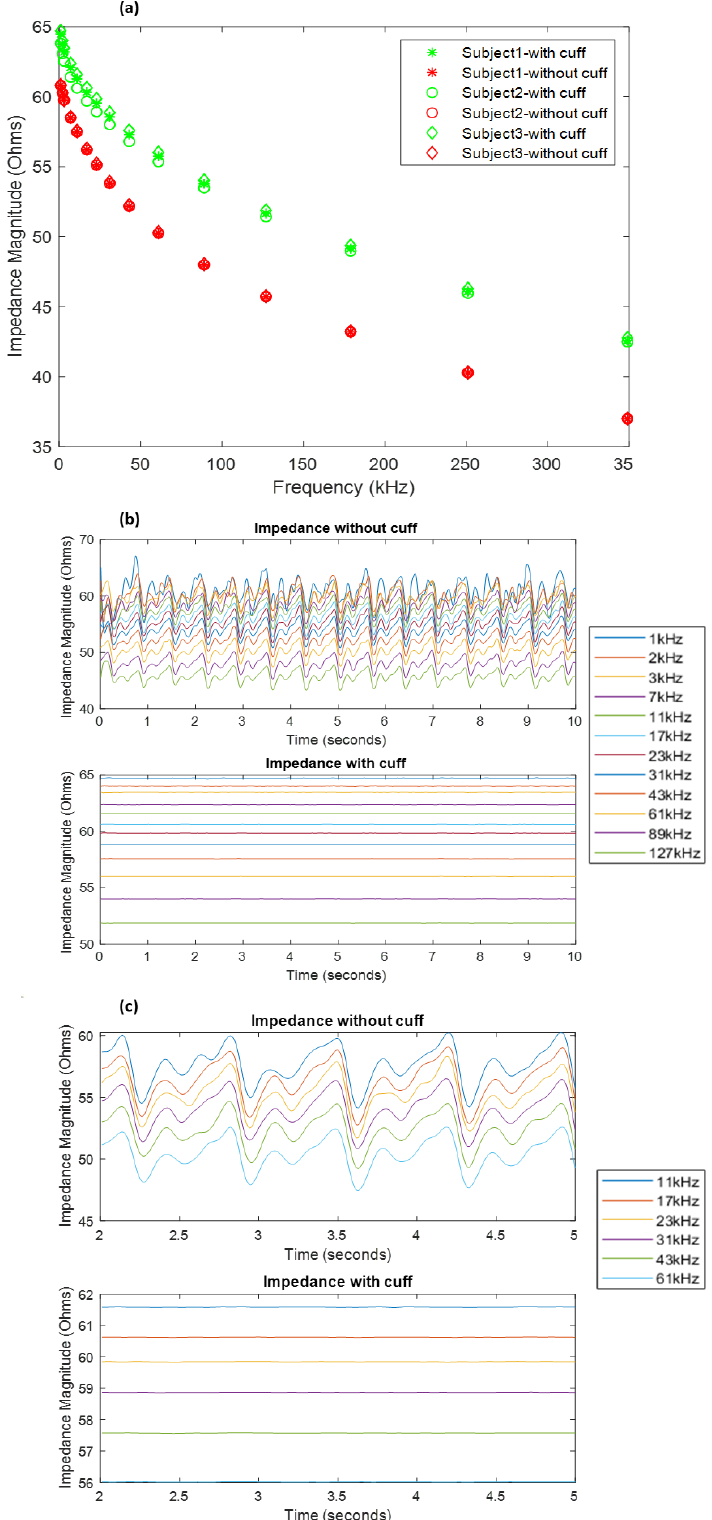
Figure 3. ( a ) Impedance spectra for subjects 1, 2 and 3 as measured by Quadra ® impedance spectroscopy device, with and without the application of cuff pressure. ( b ) Impedance waveforms measured within 1–127 kHz for subject 3, without and with cuff application. ( c ) Detailed insight into impedance waveforms within 11–61 kHz within a time interval of 2 to 5 s.